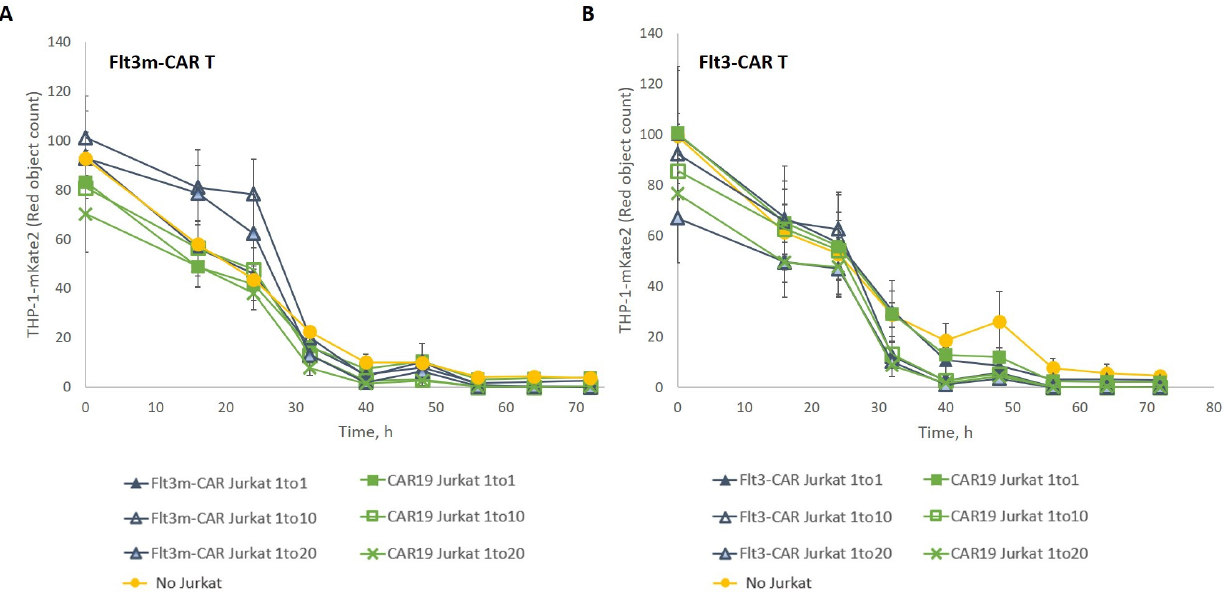
Figure 7. An excess of Flt3m-CAR Jurkat cells or Flt3-CAR Jurkat cells did not disrupt Flt3m-CAR T-cell- or Flt3-CAR T-cell-mediated killing, respectively. THP-1-mKate2 cells were incubated with either Flt3m-CAR T-cells ( A ) or Flt3-CAR T-cells ( B ) (E:T = 1:1) in the presence of different amounts (1 × ; 10 × , 20 × ) of Flt3m-CAR Jurkat cells or Flt3-CAR Jurkat cells, respectively. Triangles refer to Flt3m-CAR Jurkat ( A ) or Flt3-CAR Jurkat ( B ), with filled triangles referring to 1 × , light blue triangles to 10 × excess, and empty triangles to 20 × excess. Green curves refer to CAR19 Jurkat cells ( A , B ), with filled squares referring to 1 × , empty squares to 10 × excess, and crosses to 20 × excess. Yellow circles refer to control curves where no Jurkat cells were added ( A , B ). Data are represented as mean ±